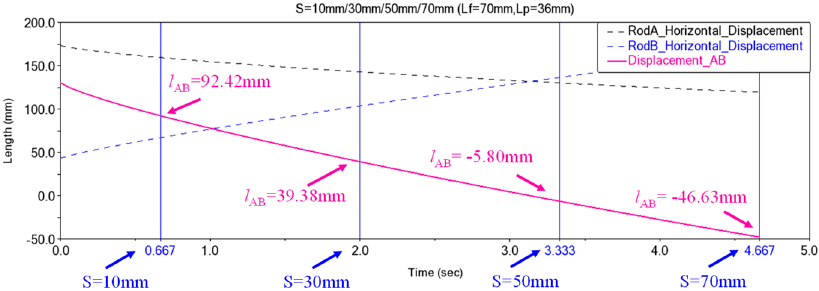
Figure 12. The change rule of the displacement AB in different push rod distance.